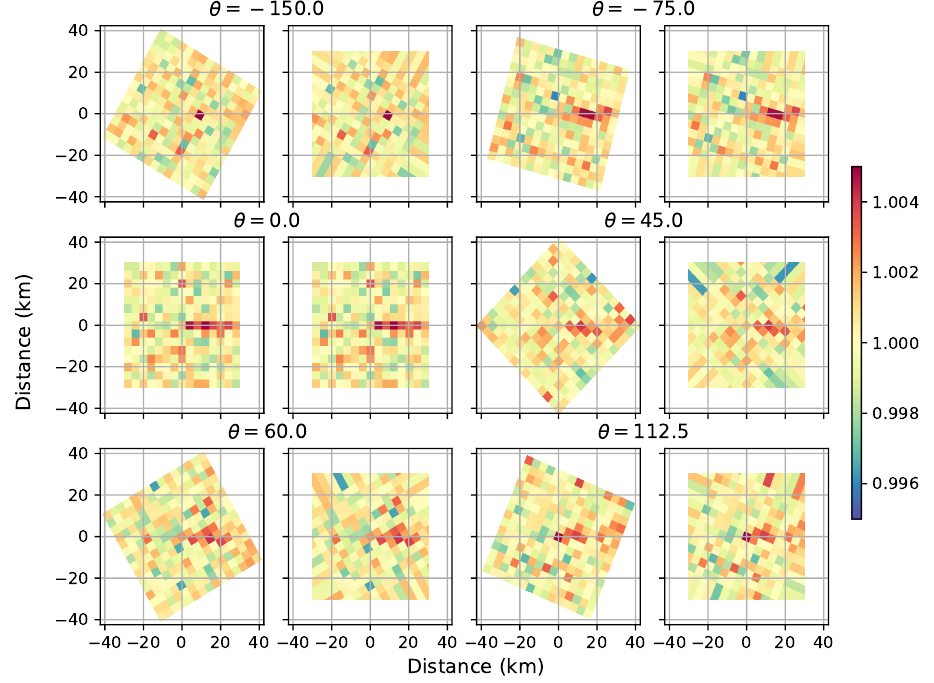
Figure 4. Simulated noisy XCO 2 observations relative to a 400 ppm background for 4 × 4 km 2 pixels after rotating to align the plumes and interpolating the rotated grids back onto a regular grid aligned with the plume. Columns 1 and 3 show the images at their 4 km × 4 km pixel resolution immediately after rotating to align the plumes. Columns 2 and 4 show the images after interpolating onto a higher resolution (50 m) regular grid using a nearest neighbour